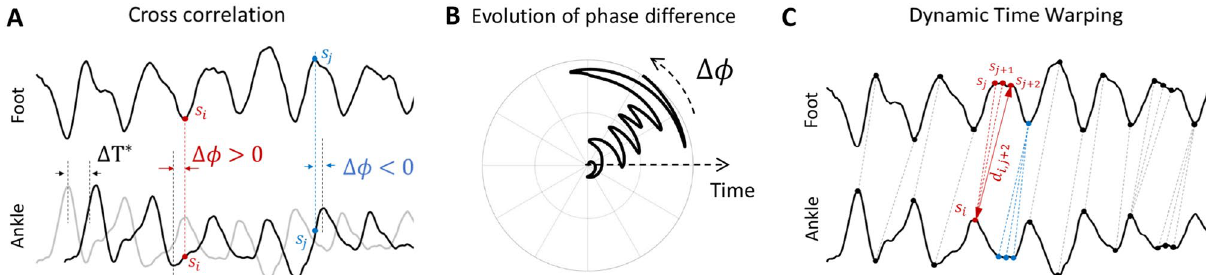
Figure 2. ( A ) Aligning foot and ankle joint angle profiles by shifting the original ankle angle (gray line) by (cid:31) T ∗ to obtain maximum cross-correlation. The peaks of the ankle angle profile are not perfectly aligned. For example, at sample s i shifted ankle angle is leading while at sample s j it is lagging behind the foot orientation. ( B ) An example of the instantaneous phase difference variation between the ankle and the foot angles with respect to time. ( C) Aligning signal samples using dynamic time warping. In this method, instead of shifting the whole ankle angle by a constant value, samples of the ankle joint profile are mapped to the samples of the foot profile. For example, sample s i , representing a peak in ankle angle, is mapped to samples s j to s j + 2 since all those samples are representing the corresponding peak at the foot angle profile. The mapping is not injective and can thus account for variable delays between the